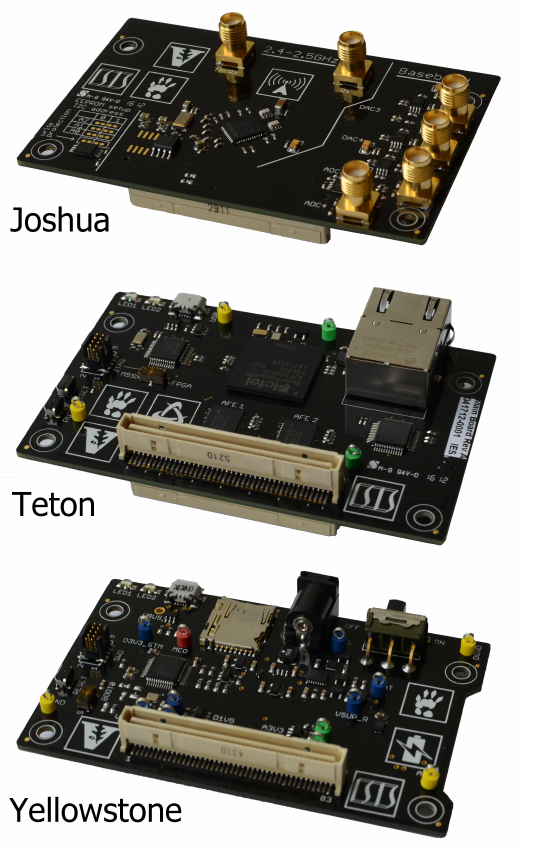
Figure 1. Photo ( left ) and block diagram ( right ) of the three-layer Marmote SDR platform comprising a Joshua 2.4 GHz radio front-end ( top ), a Teton mixed-signal processing ( middle ) and a Yellowstone battery-operated power management ( bottom )